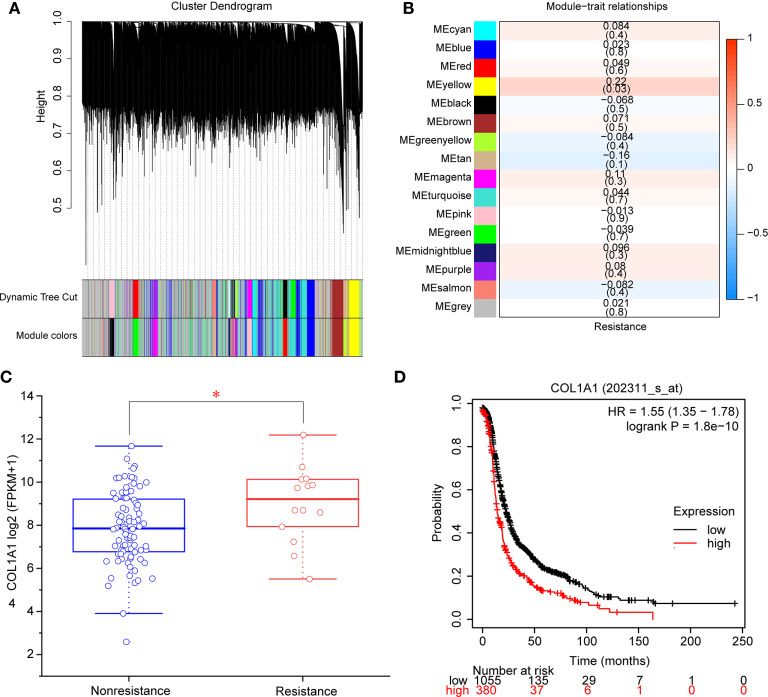
Identification of modules and genes associated with carboplatin-resistant OV. (A) Dendrogram of 8,791 genes in the top 70% median absolute deviations clustered based on a dissimilarity measure (1-TOM). (B) Heatmap of the correlation between module eigengenes and clinical traits. Each cell contains the correlation coefficient and p-value. (C) mRNA expression of COL1A1 in carboplatin-nonresistant OV (n = 84) and carboplatin-resistant OV (n = 14). *p < 0.05. (D) The overall survival of patients with high expression of COL1A1 was lower than that of patients with low expression (p < 0.05).